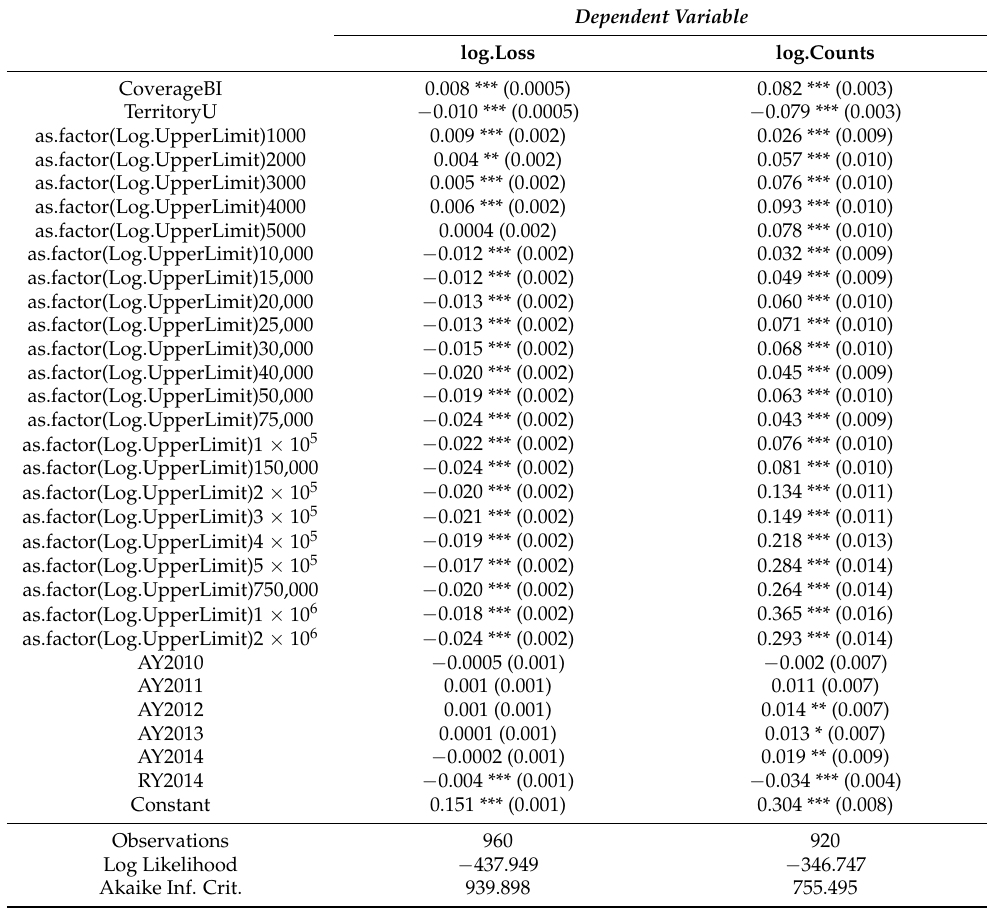
Table 3. GLM model output for gamma as the link function. In the second and third column, the first value represents the coefficient of the factor level and the value next to the coefficient estimate (which is the one with bracket) is the standard error of the estimated